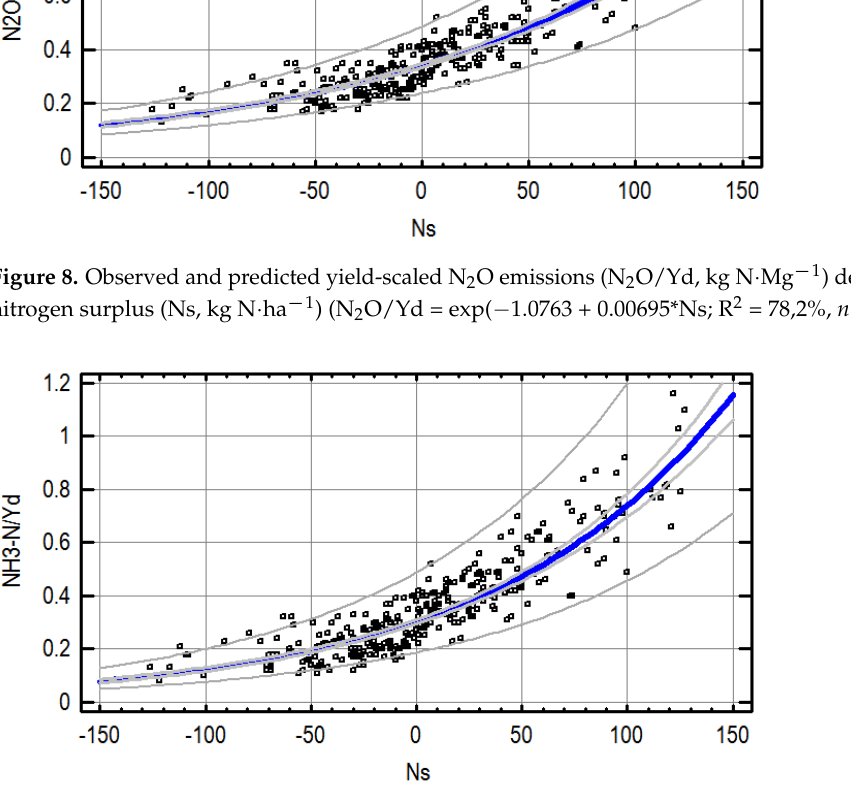
693 3.7. Nitrogen Indicators for Farm Fields In the dataset from farm fields for which NUE was ≥90%, the medians were yield - 6.00 Mg·ha − 1 , NUE – 118%, and Ns-26 kg N·ha − 1 (Table 3). The corresponding yield-scaled N losses were as follows: Ns −4.2, N 2 O 0.30, and NH 3 0.23 kg N·ha − 1 . The obtained gross margin reached the value of 746 EUR·ha − 1 .